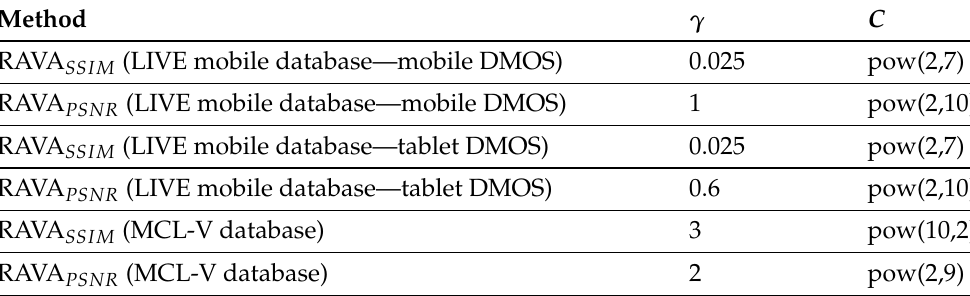
Table 1. Values assigned to γ and C for the LIVE mobile database and the MCL-V